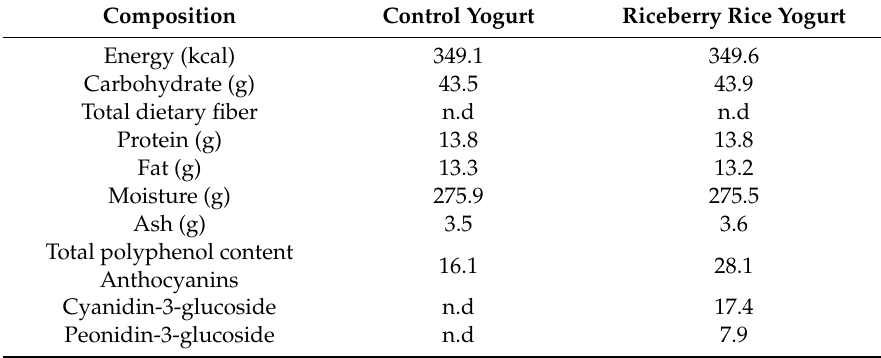
Table 1. The nutritional composition and phytochemical compounds of yogurt for one serving size (350